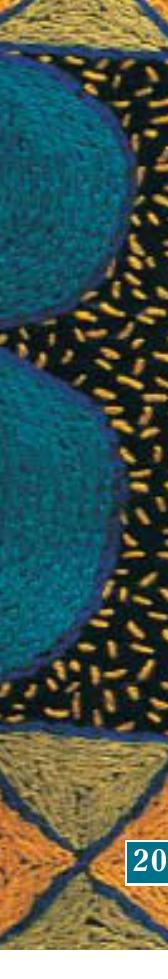
Fig. 3. ‘Acute infection’ and